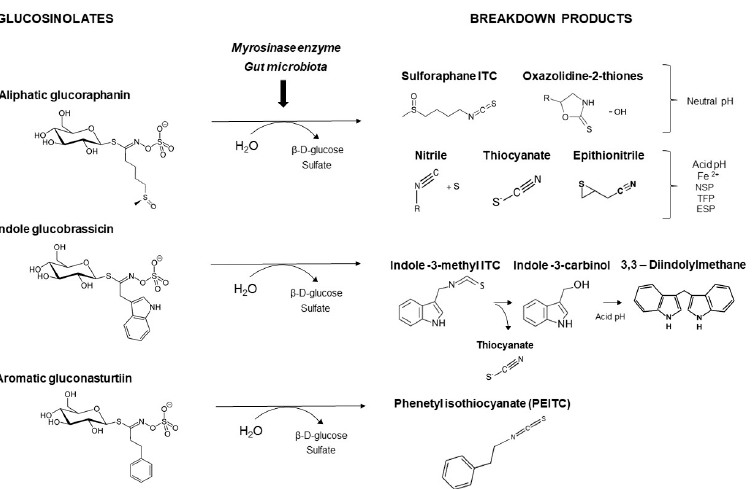
Figure 1. Scheme of the conversion of aliphatic, indolic, and aromatic glucosinolates to breakdown products by plant and intestinal myrosinase activity. ESP, epithiospecifier protein; ITC, isothiocyanate; NSP, nitrile specifier protein; TFP, thiocyanate-forming protein (Modified from Baenas and Wagner, 2019) [18].